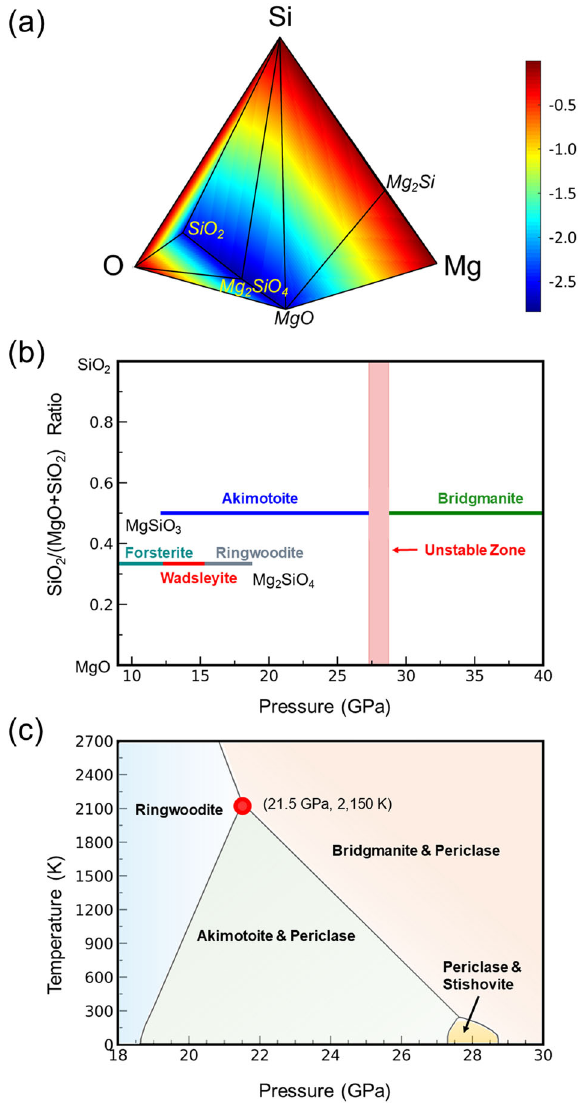
Fig. 5 Thermodynamics of Mg – Si – O system. a Mg – Si – O convex hull with energies of formation (in eV atom − 1 , with scale shown by color bar) of the sampled structures at ambient pressure. b Pressure- composition phase diagram of the MgO – SiO 2 system. c Pressure – temperature phase diagram of Mg 2 SiO 4 and its decom- position pathways. The triple point between phases ringwoodite- bridgmanite + periclase-akimotoite + periclase is highlighted by red